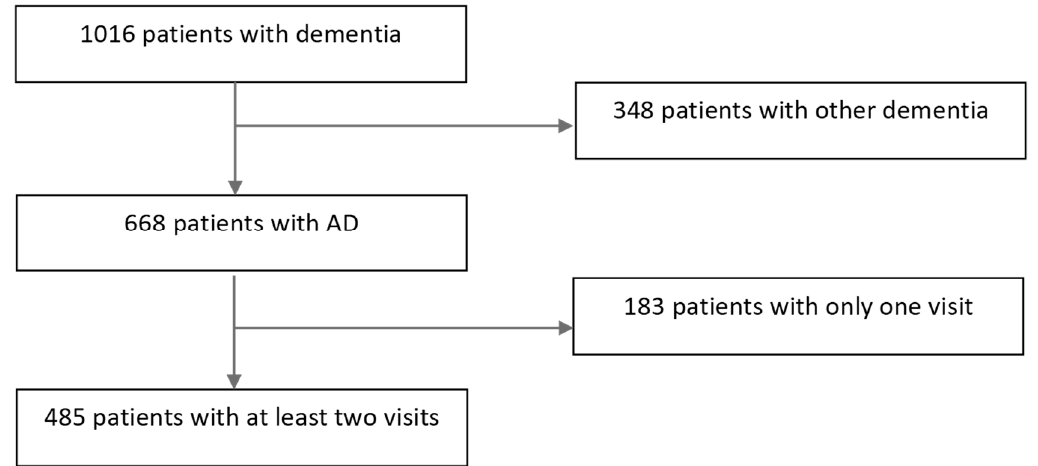
Figure 1. Flowchart.AD = Alzheimer’s disease.